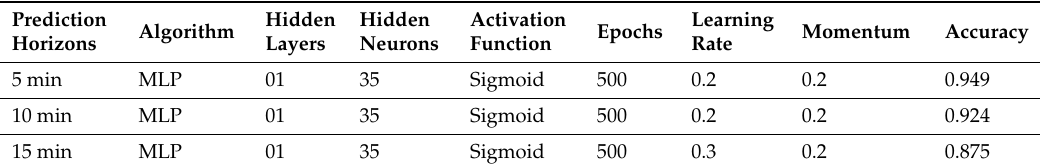
Table 3. Configuration of the parameters for the multi-layer perceptron (MLP).